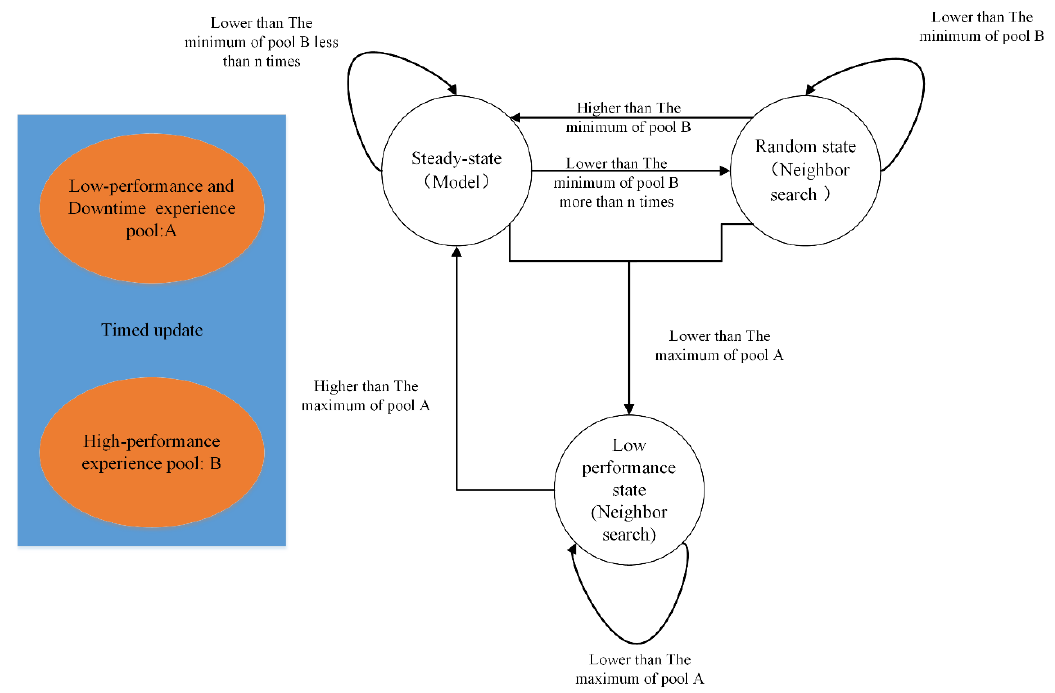
Figure 5. State machine process in